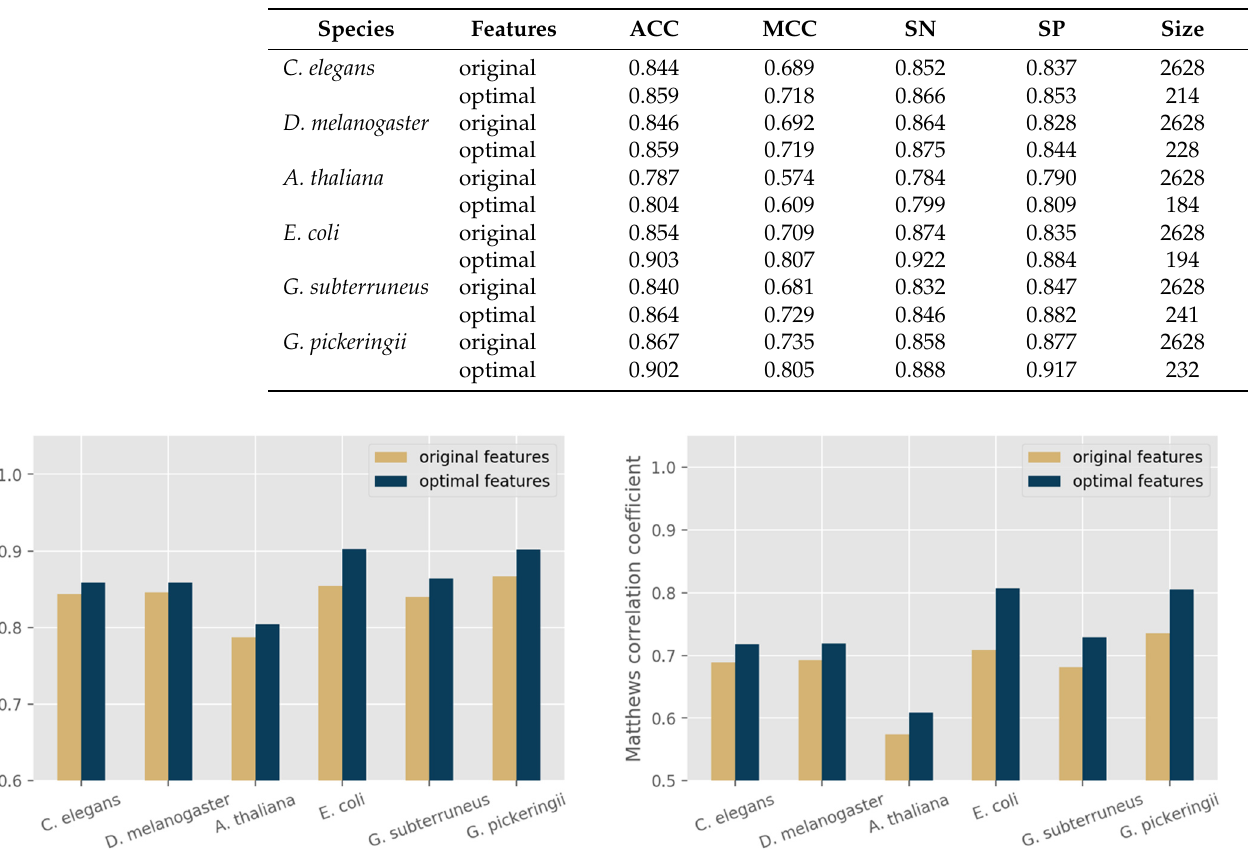
Figure 3. Accuracies of the proposed features on datasets from Caenorhabditis elegans , Drosophila melanogaster , Arabidopsis thaliana , Escherichia coli , Geoalkalibacter subterraneus, and Geobacter pickeringii as the number of selected features increases. Table 2. Comparison between the original features and optimal features.